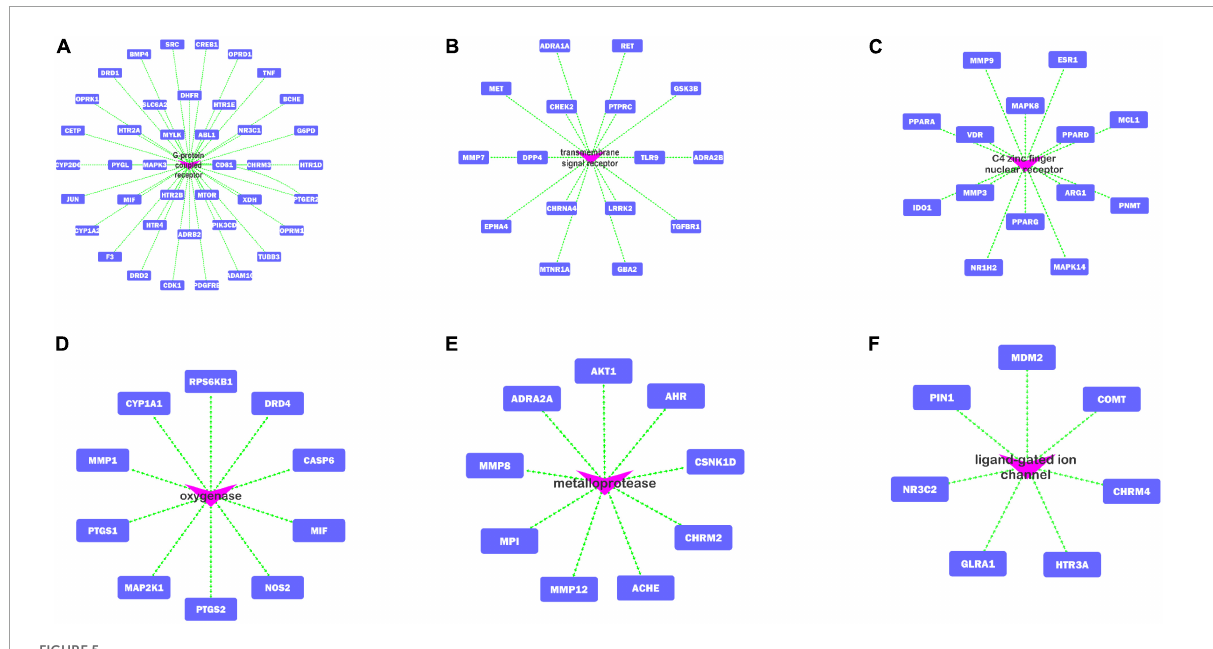
FIGURE5 (A–F) Top 6 pathway-target gene